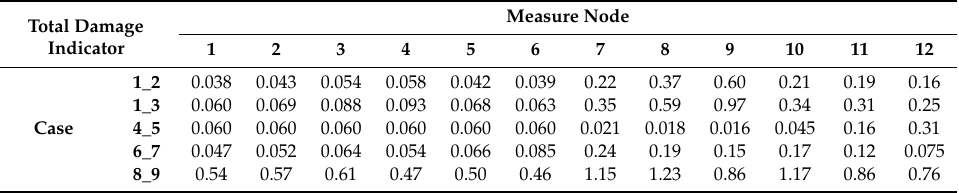
Table 7. Total damage indicators of every case using the TVSTR